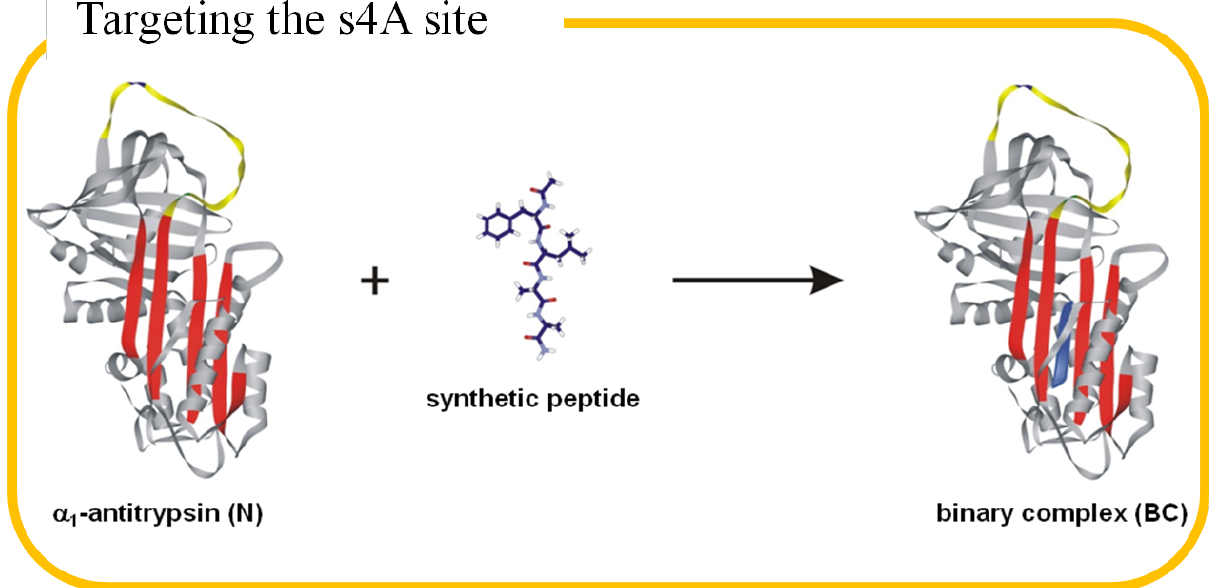
Figure 1. Targeting the s4A site on the β-sheet of α -antitrypsin (AT). The native AT 1 (PDB code: 1QLP) contains a reactive center loop (yellow) and a β-sheet A (red) which are the starting points of the pathogenic polymerization. The five strands of the β-sheet are termed as s1A, s2A, s3A, s5A and s6A (from left to right). The synthetic peptide (blue) inserts into the s4A position to form binary complex (BC) and thus blocks the propagation of